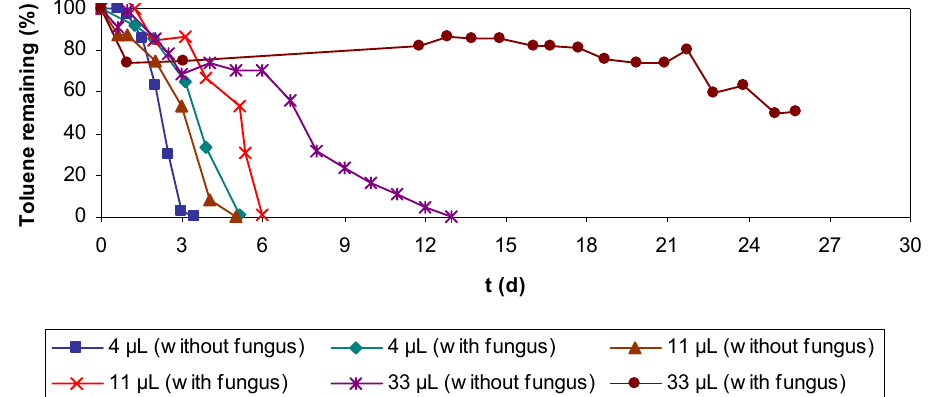
Figure 13. Batch assays with and without fungus (0.3 g VSS L; OD about 0.65–0.70 A ) at 20 °C and different volumes of injected